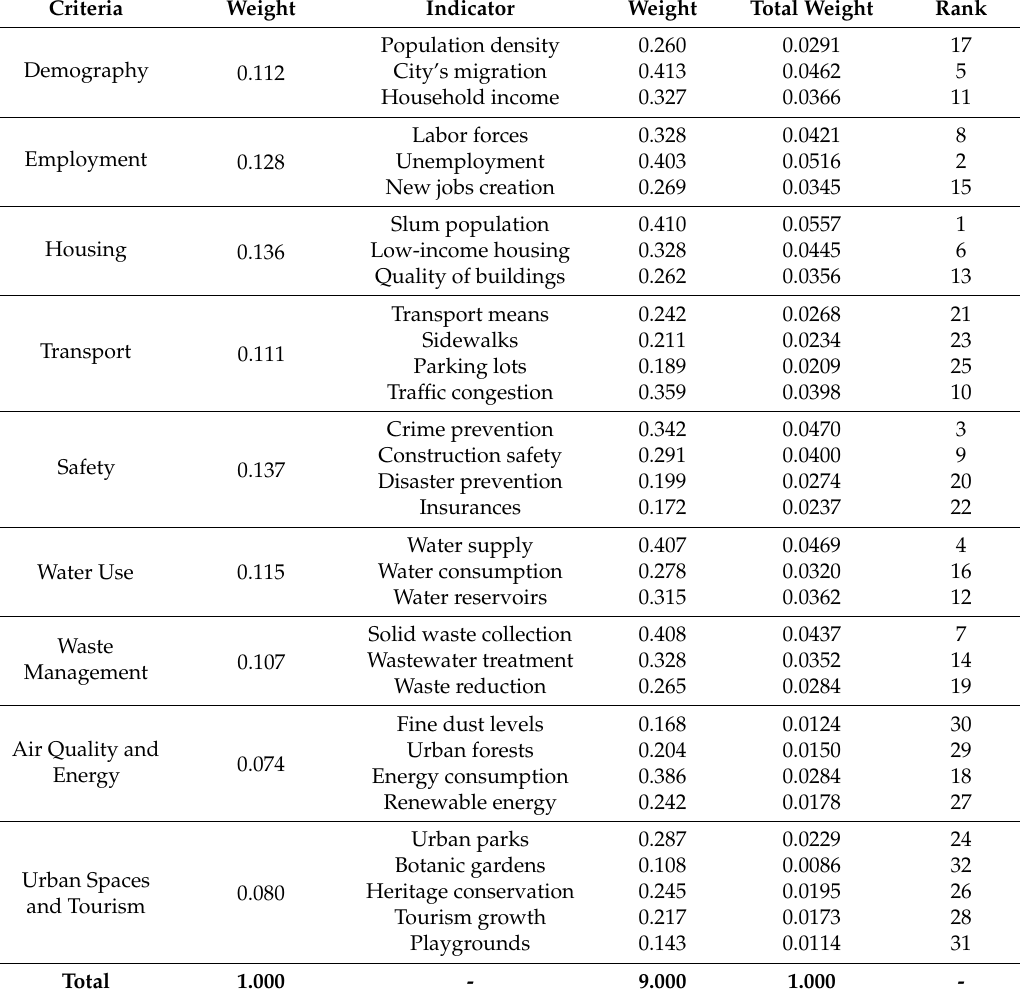
Table 3. Priority weights of the nine criteria and their assessment indicators and total weights of all indicator and their